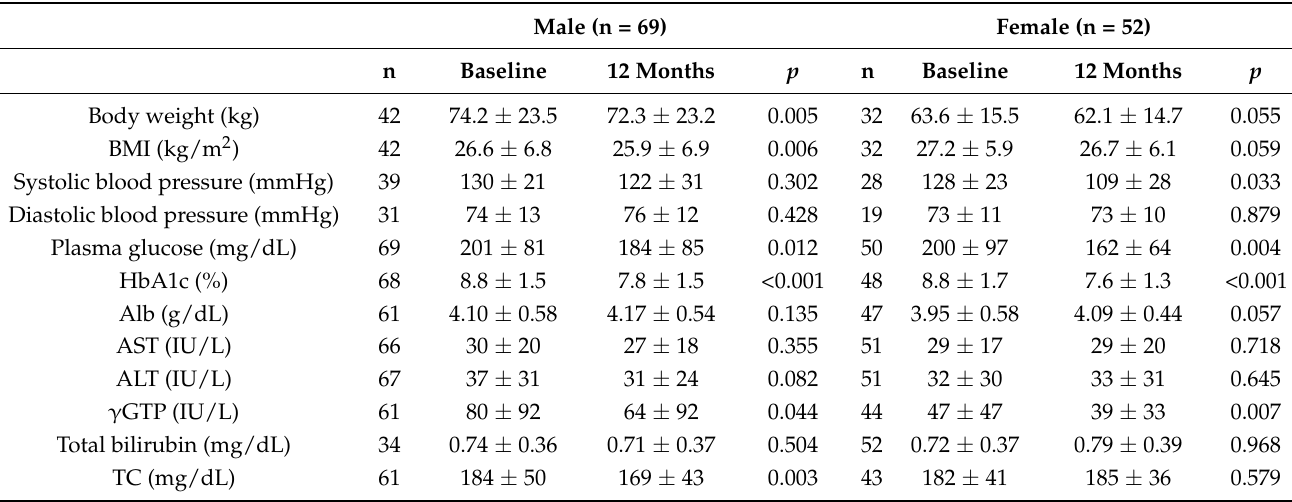
Table 3. Change in the clinical parameters 12 months after the start of dulaglutide in male and female